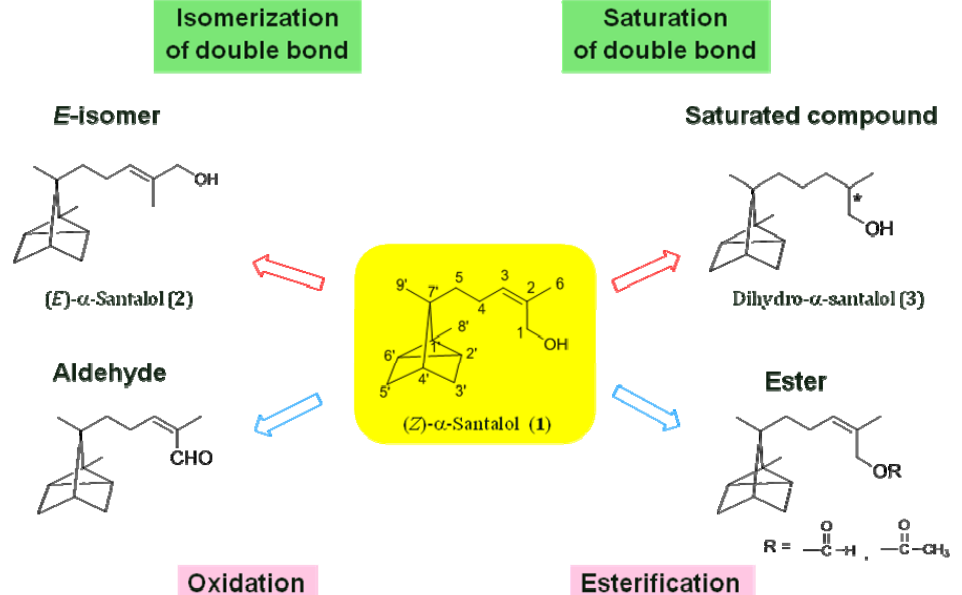
Figure 2. Structure–odor relationships of α -santalols considering the double bond and functional group of the side